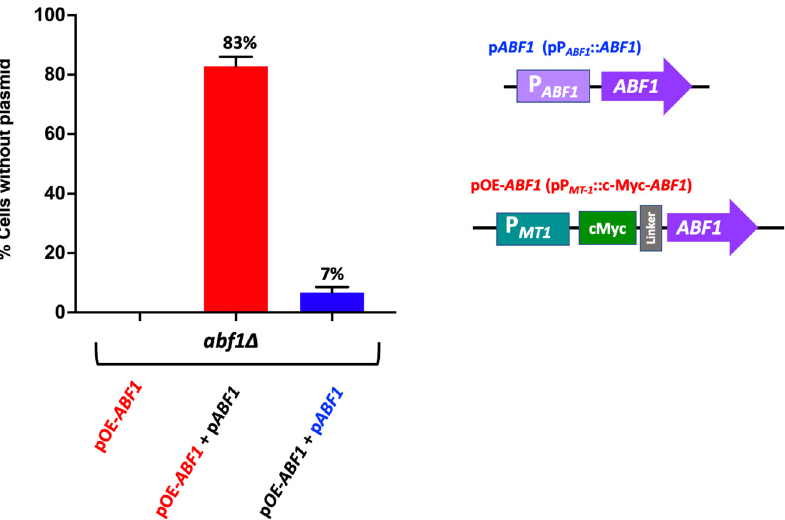
Figure 4. Over expression of ABF1 is toxic in C. glabrata . Schematic representation of the plasmids transformed in the abf1 ∆ strain. The first plasmid contains the full-length ABF1 gene driven by its own promoter (p ABF1 +) and a second plasmid with the amino-terminal tagged version (c-Myc) of ABF1 driven by the overexpressing promoter from MT-1 gene (pOE- ABF1 ). These plasmids were transformed simultaneously, and the loss of each plasmid was determined after passages every 12 h for 72 h in rich media YPD (without selection). The graph shows the percentage of cells that lost the corresponding plasmid (the mean of three independent experiments ± SD, see in Section 2.6). The red bar indicates loss of the over-expressing plasmid pc-Myc- ABF1 (OE- ABF1 ); the blue bar indicates loss of the plasmid p ABF1 .